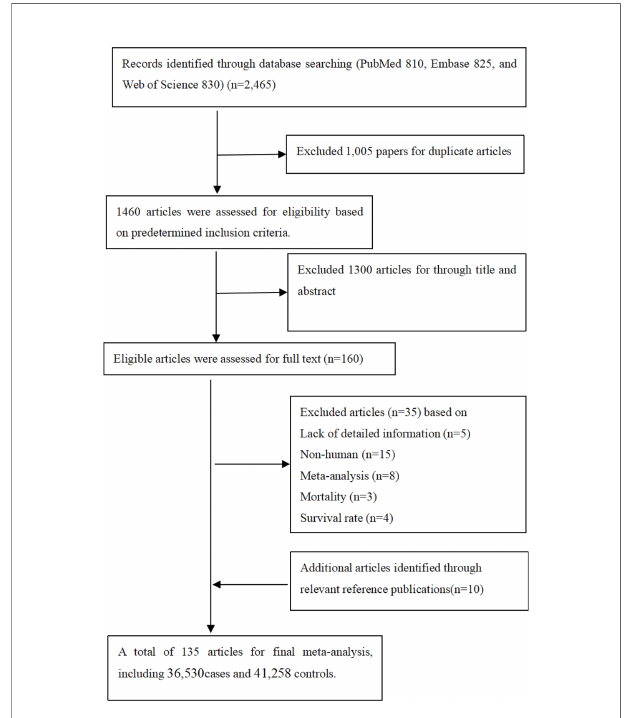
FIGURE 1 | Flow diagram of search strategy and study